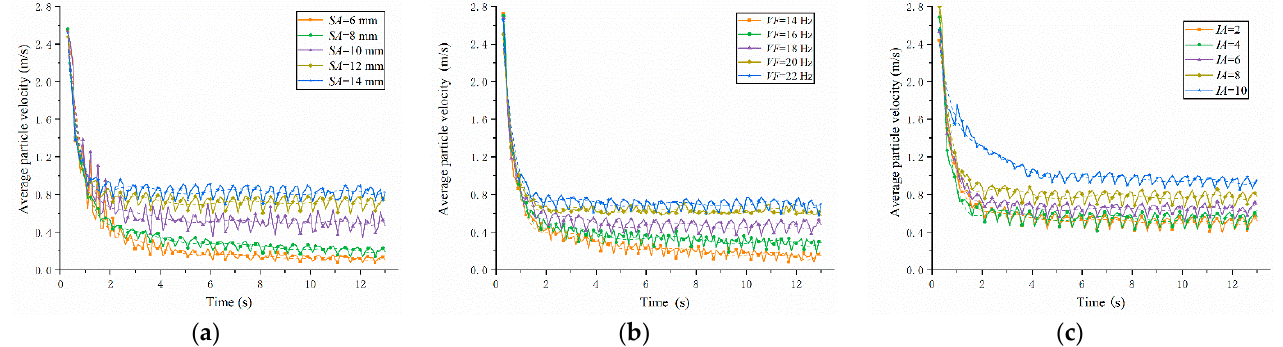
Figure 8. Curve of the average velocity of the particles. ( a ) Curve of the average velocity of the particles with amplitude; ( b ) Curve of the average velocity of the particles with frequency; ( c ) Curve of the average velocity of the particles with angle.